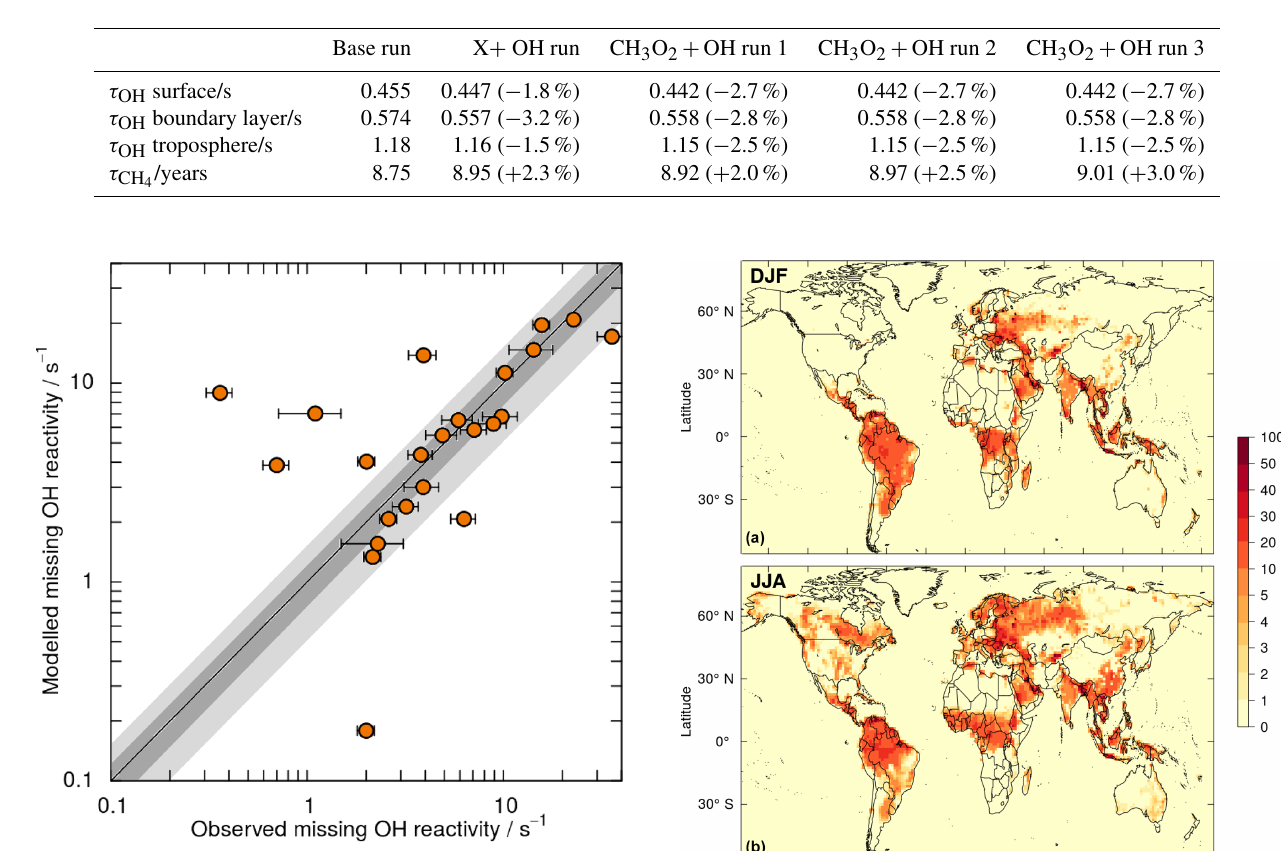
Table 4. Values of the OH and methane lifetimes in the model runs described in this work. Numbers in brackets indicate the percentage change with respect to the base run.